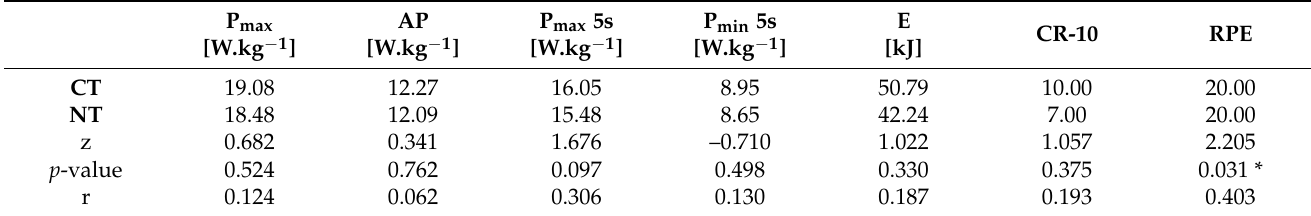
Table 3. Wilcoxon signed-rank test